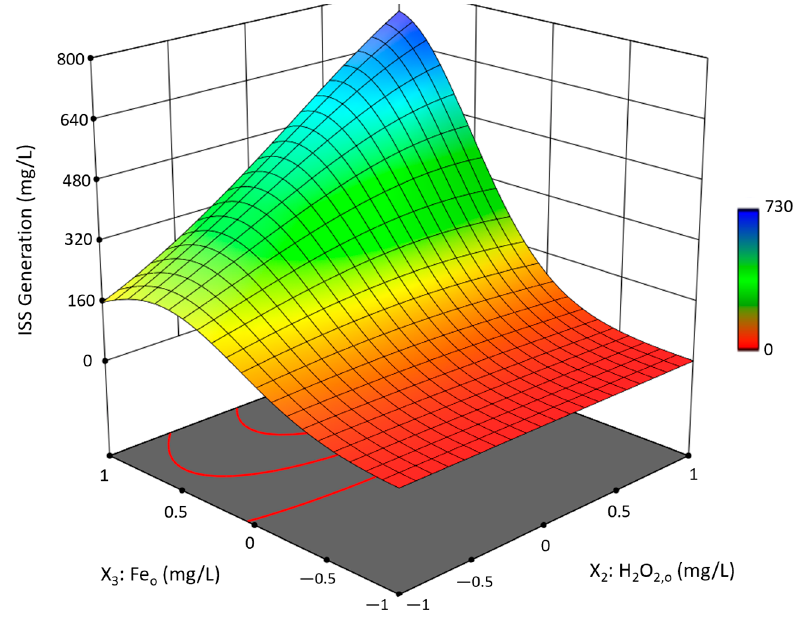
Figure 5. 3D plot of the cross-factor interaction effects between H 2 O 2,o and Fe o (X 2 X 3 ) on ISS generation (Y 3 ) at reaction time of 4 h.